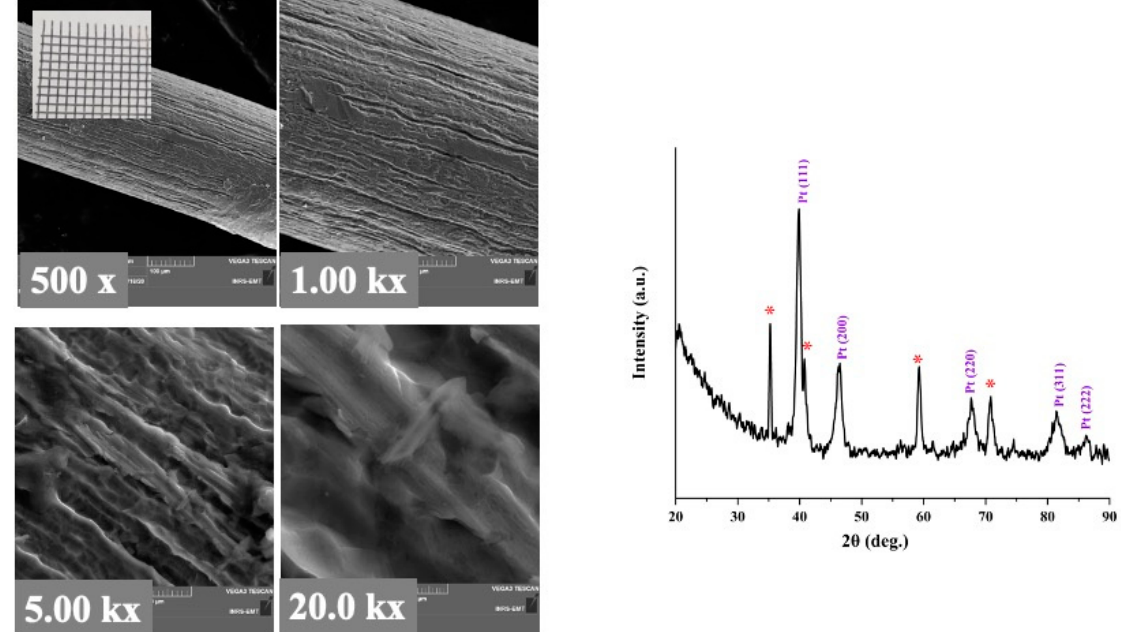
Figure 4. SEM micrographs at increasing magnifications of Pt grown by PLD on Ti mesh. Inset at the top left of the figure is a photograph of Pt/Ti mesh. The figure on the right side is the XRD analysis of Pt/Ti mesh. (*) Corresponds to the TiO 2 substrate.